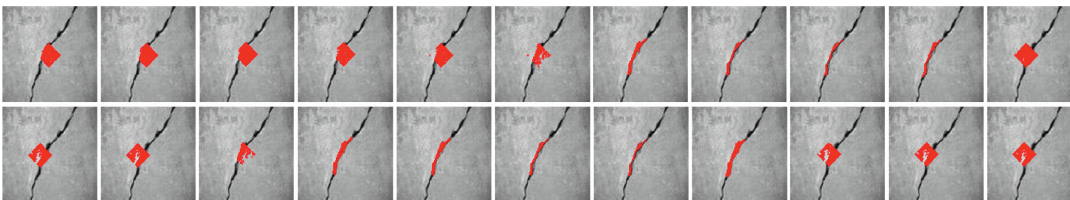
Figure 14: Percolated results using the conditional termination